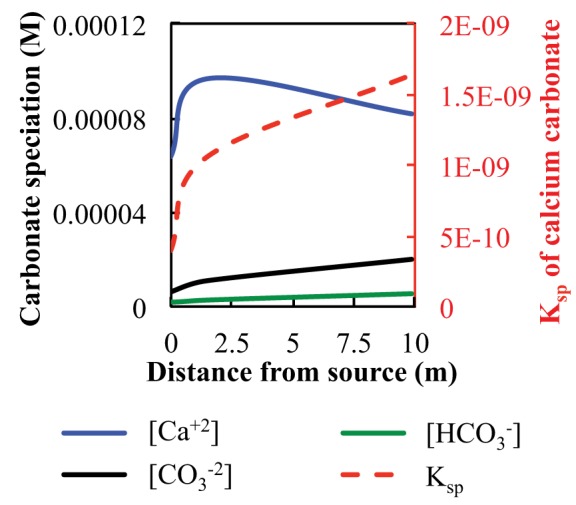
Fluid carbonate species concentration, in M, and calculated Ksp of CaCO3 at Manleluag, plotted on a secondary axis (dashed line, red).